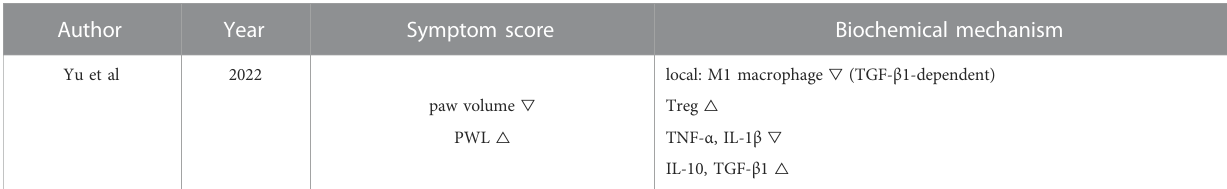
TABLE 2 ( Continued ) Symptom score change by acupuncture treatment and the underlying mechanisms.